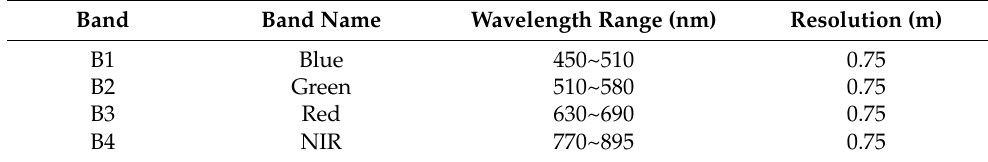
Table 1. Spectral bands for the JL-1 satellite.